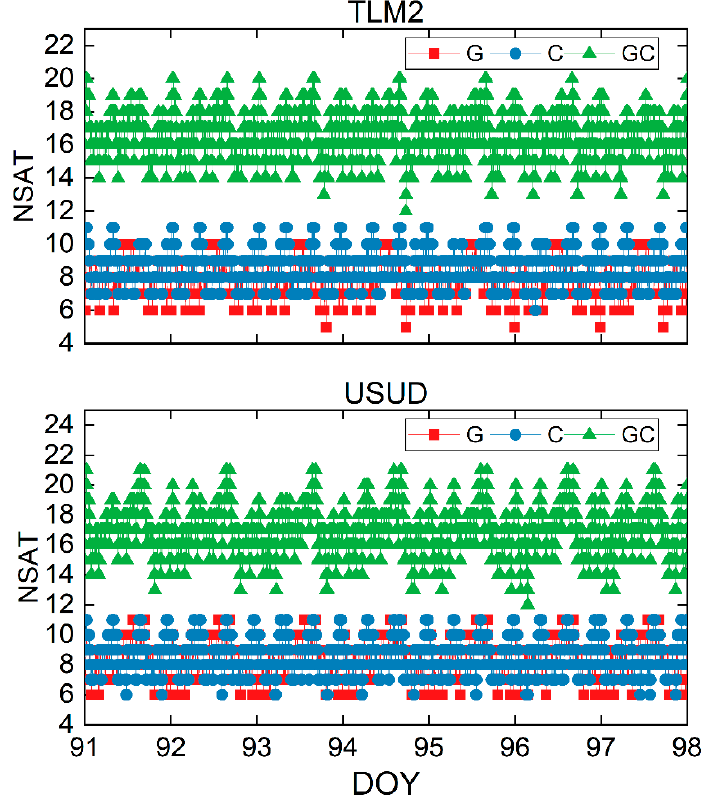
Figure 14. Number of visible satellites (NSAT) for TLM2 ( top ) and USUD ( bottom ) stations at a mask angle of 10°.